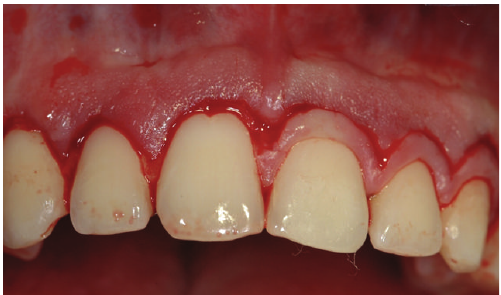
Figure 3: Periapical X-ray of the upper anterior teeth to plan sub- marginal incision (see test for explanation).